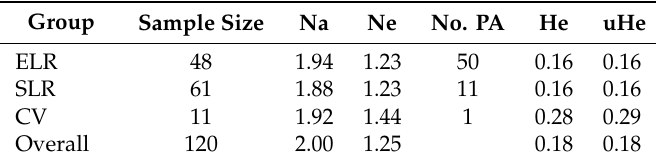
Table 2. Genetic diversity indices calculated within the di ff erent accessions groups and based on the 2470 single nucleotide polymorphisms